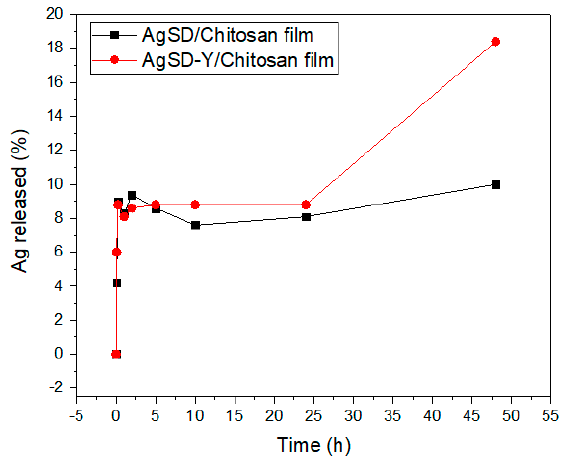
Figure 12. release-test from AgSD/Chitosan film and AgSD-Y/Chitosan film. Figure 12. Release-test from AgSD / Chitosan film and AgSD-Y / Chitosan